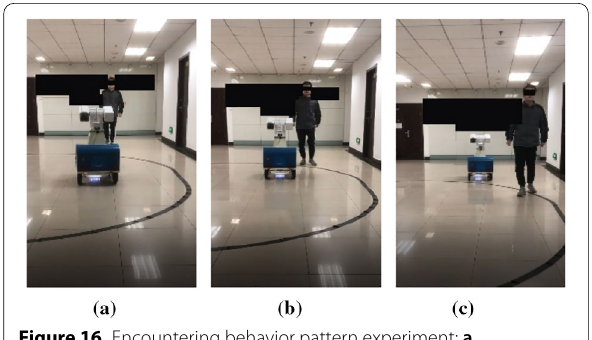
Figure 16 Encountering behavior pattern experiment: a approaching robot, b robot decelerates to avoid, c human departure